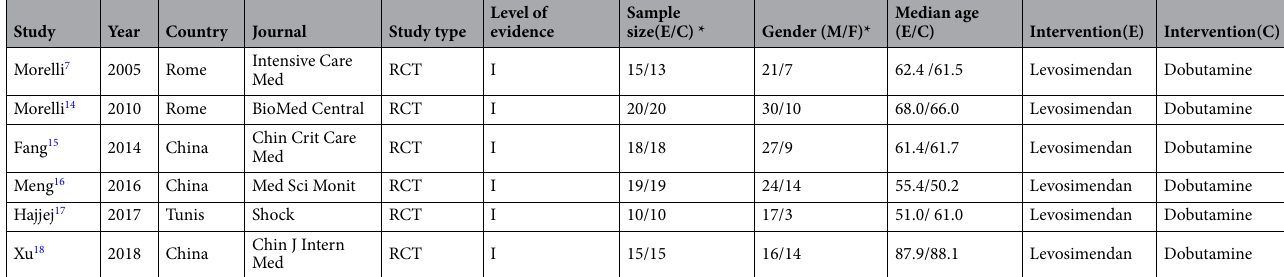
Table 3. Characteristics of the studies in meta-analysis. E experimental group; C controlled group; RCT randomized controlled trials.